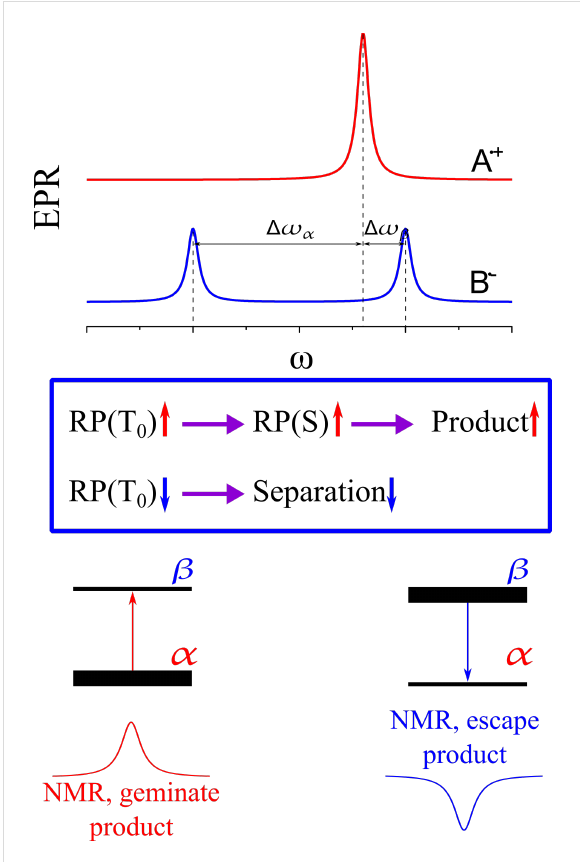
Figure 11: Scheme of CIDNP formation by spin sorting at high mag- netic fields. Top: EPR spectra of the two radicals – one radical has a single spin-1/2 nucleus resulting in splitting of the EPR line into two components; the other radical has no nuclei, i.e., a single EPR line. The difference in EPR frequencies, Δω α and Δω β , are indicated for the radical pairs with the nucleus in the α -state and β -state, respectively. Since Δω α ≠ Δω β , the S – T 0 interconversion rate is different for the two nuclear spin states. Middle: Kinetic scheme of CIDNP formation – a triplet-born radical pair in the T 0 state rapidly goes to the reactive single state for the α nuclear spin state, resulting in a reaction product enriched in this nuclear spin state. For the β nuclear spin state, radical pairs react less efficiently and undergo separation. Bottom: The gemi- nate reaction product is enriched in the α nuclear spin state giving an NMR line with enhanced absorption, whereas for reaction products of the escaped radicals, the opposite sign of polarization and opposite CIDNP sign is